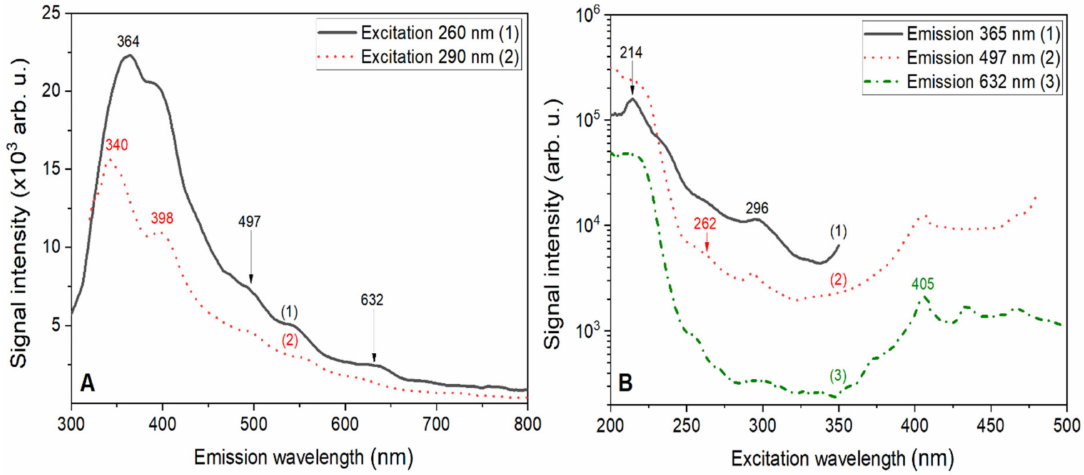
Figure 4. Photoluminescence (PL) emission ( A ) and excitation ( B ) spectra measured for the undoped LiMgPO 4 crystal investigated within this work. The excitation wavelengths in ( A ) (260 and 290 nm) corresponded to the maxima in the excitation spectra in ( B ). The emission channels in ( B )